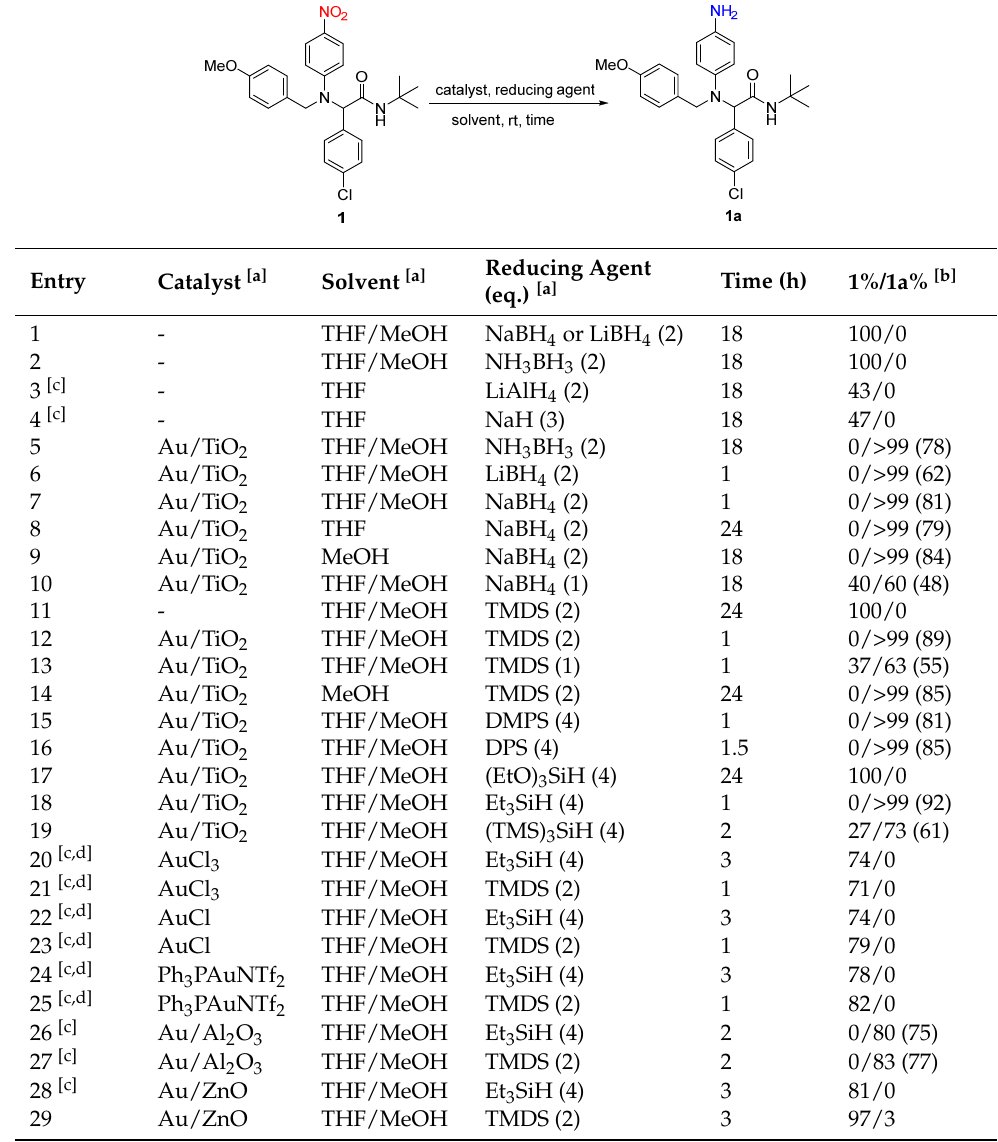
Table 1. Evaluation of Au catalysts, reducing agents and solvents in the catalytic reduction of 1 into 1a .